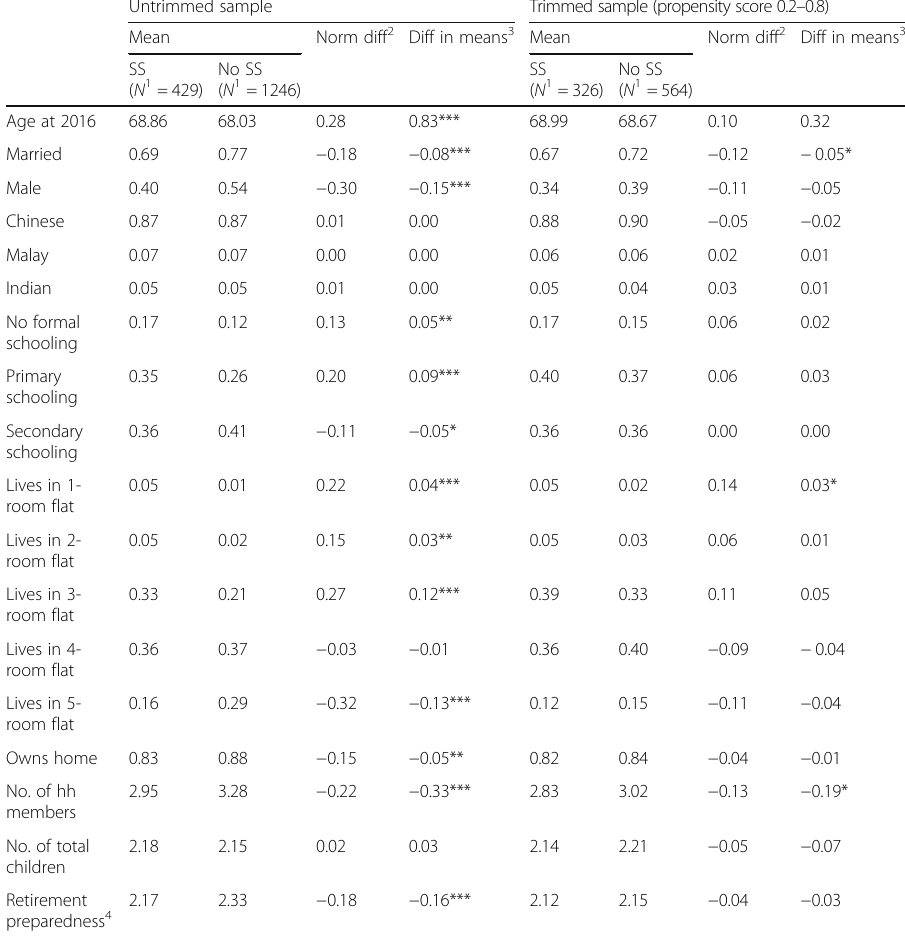
Table 1 Summary statistics for baseline demographics — comparison between those who received and did not receive SSS payout, among individuals aged 65 and above in